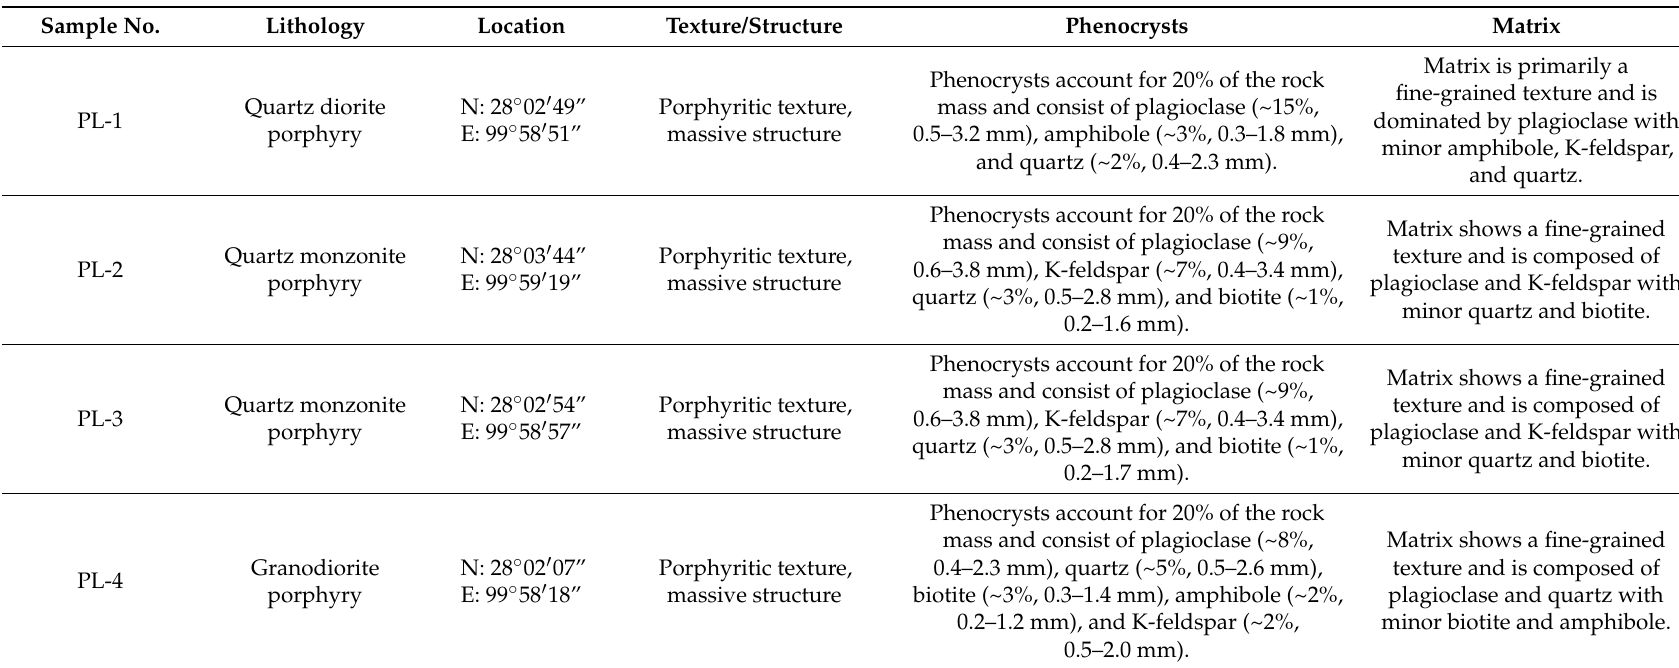
Table 1. Characteristics of the porphyry intrusions in the Pulang ore